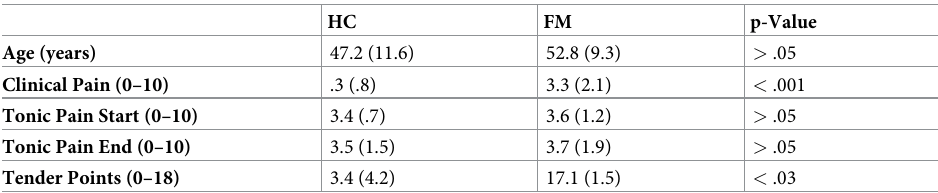
Table 1. Characteristics of study